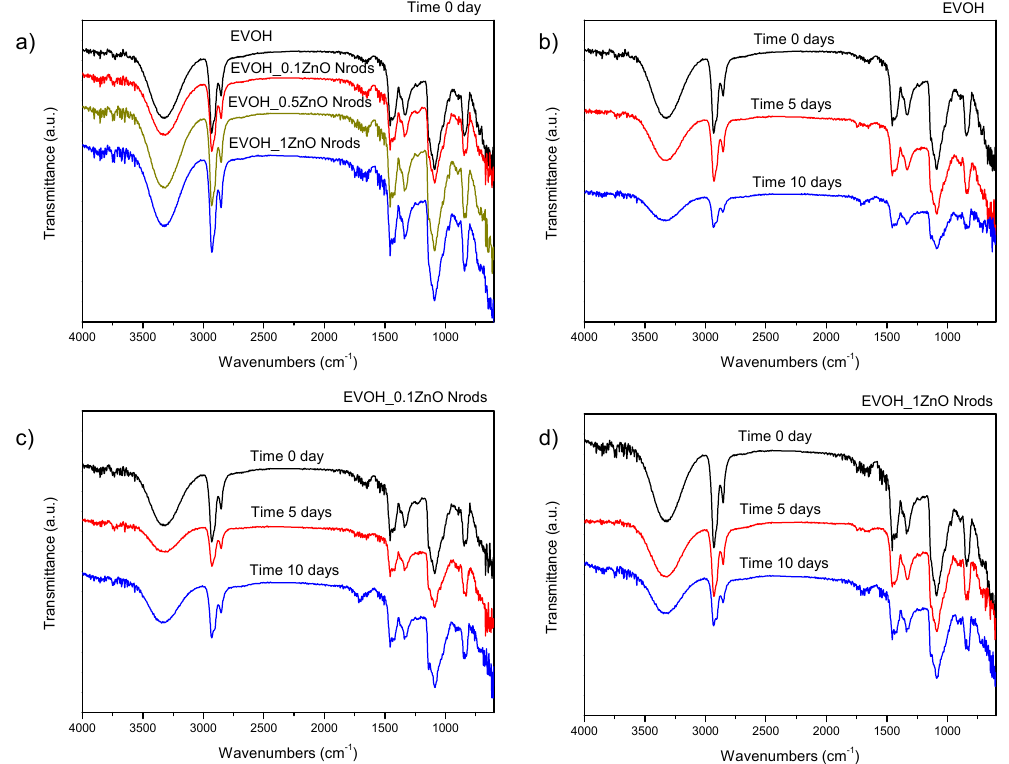
Figure 4. FT-IR spectra of EVOH and EVOH_ ZnO Nrods at different ZnO contents at time 0 (a), and after different exposition times (5 and 10 days) of accelerated-aging test for EVOH ( b ), EVOH_0.1ZnO Nrods ( c ) and EVOH_1ZnO Nrods ( d ).